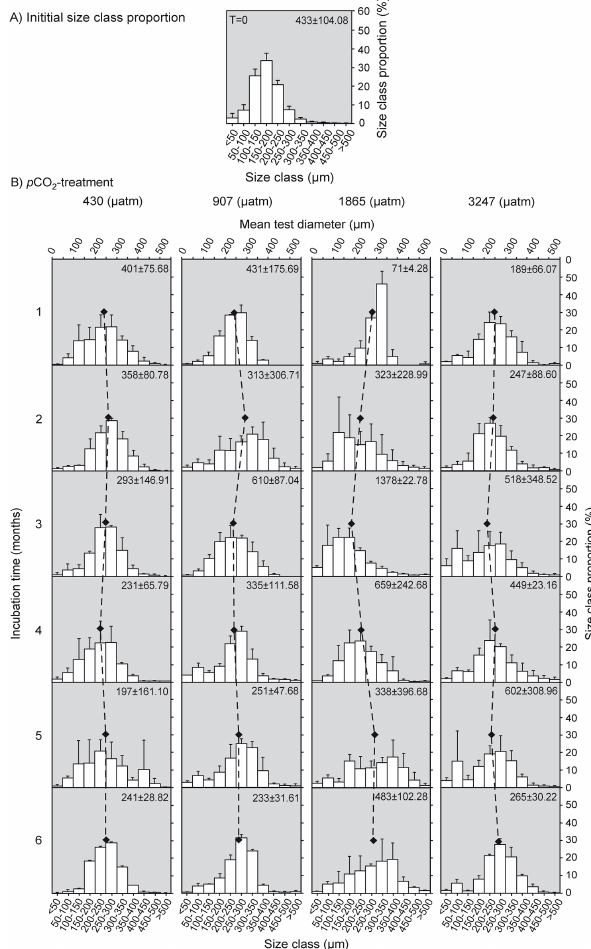
Fig. 4. Histogram of living A. aomoriensis , (A) initial size class proportions ( T = 0) and (B) size class proportions for the tested four p CO 2 levels (430, 907, 1865 and 3247µatm) during 6 months of incubation. Bars represent relative proportion of 11 size classes ranging from < 50 until > 500µm in 50µm intervals. Mean test di- ameter (B) is displayed by the black diamonds and dashed lines. The number in each figure represents the mean population density ± SD, which refers to replicate measurements (Table S3 in the Sup-